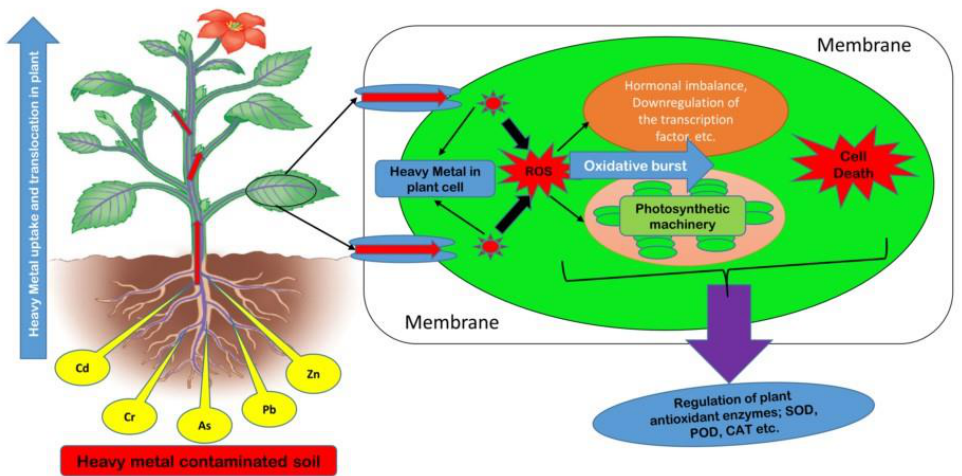
Figure 9. The mechanism of metal stress and oxidative damage in plant cells. Plants uptake an excess amount of heavy metals, which leads to the overproduction of ROS. These ROS cause an oxidative burst and affect a variety of plant biochemical activities in the plant cell.